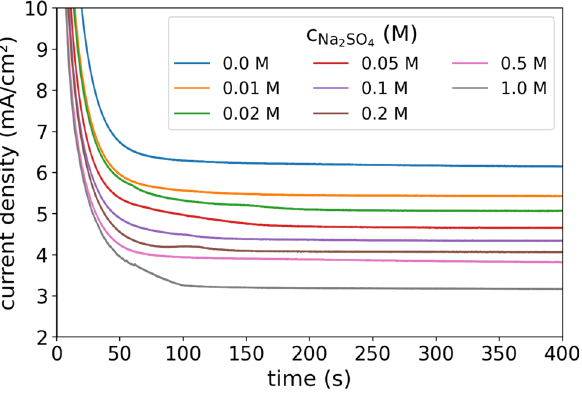
Figure 2. Measured current densities at 0.3 V between two copper electrodes (distance of 500 µm) with a CuSO 4 concentration of 0.1 M and a variation of the Na 2 SO 4 concentration from 0 to 1